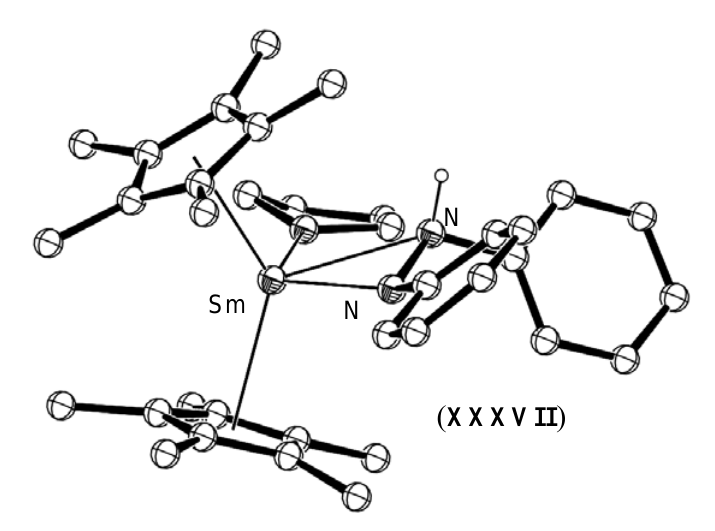
Figure 15. Molecular structure of [(C Figure generated from CCDC obtained coordinates. Atoms of arbitrary size. Non- hydrazine H atoms are omitted for